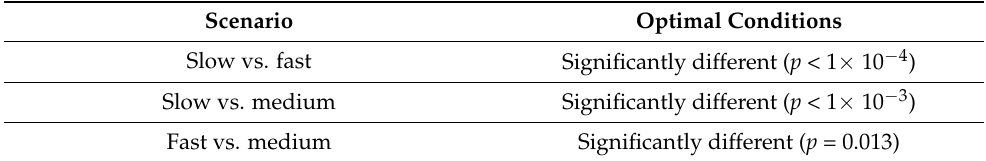
Table 6. Results of Friedman’s Test with Bonferroni’s Correction to Investigate the Differences among the Three Rotation Rate Conditions.